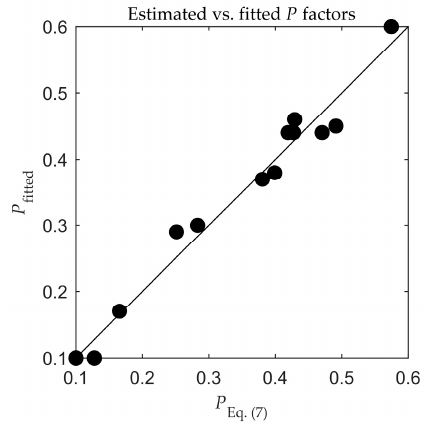
Figure 16. Comparison between the fitted P factors shown in Figure 1 and the estimated P factors calculated by Equation (7).